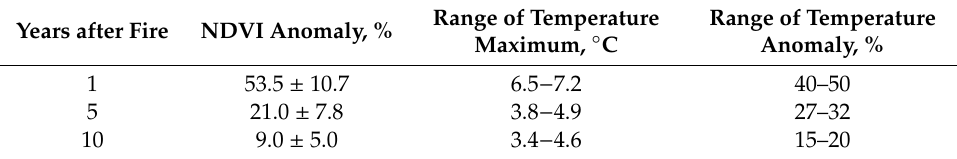
Table 3. Deviation of averaged surface temperature and normalized difference vegetation index (NDVI) for fire-disturbed plots relative to non-disturbed plots’ values (for mid-summer). Years after NDVI Anomaly, Range of Temperature Range of Temperature Fire % Maximum, °C Anomaly, % 1 53.5 ± 10.7 6.5 − 7.2 40–50 21.0 ± 7.8